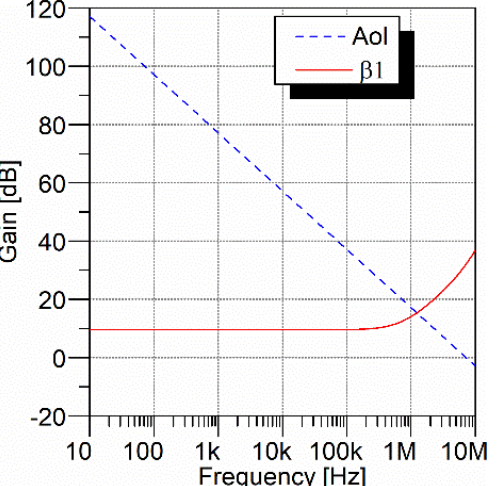
Figure 10. Simulated amplitude-frequency curves of Aol and β 1 (capacitor C5 was removed). For a more intuitive perspective, a transient analysis was performed using the circuit shown in Figure 4. V ref was set to a 10 KHz square wave with 500 mv amplitude. The waveforms of the output node ( V s ) and the input node ( V ref ) were recorded and shown in Figure 11, in which the oscillation was clearly